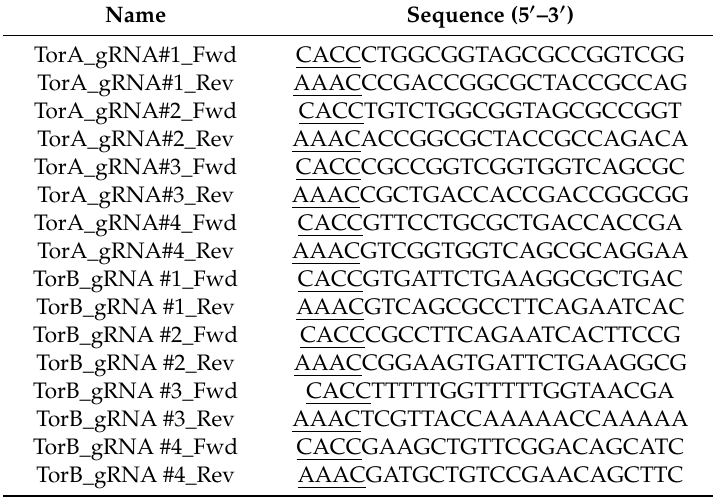
Table 1. Oligonucleotide sequences. Compatible 5 (cid:48) overhangs for restriction enzyme BbsI used for cloning are